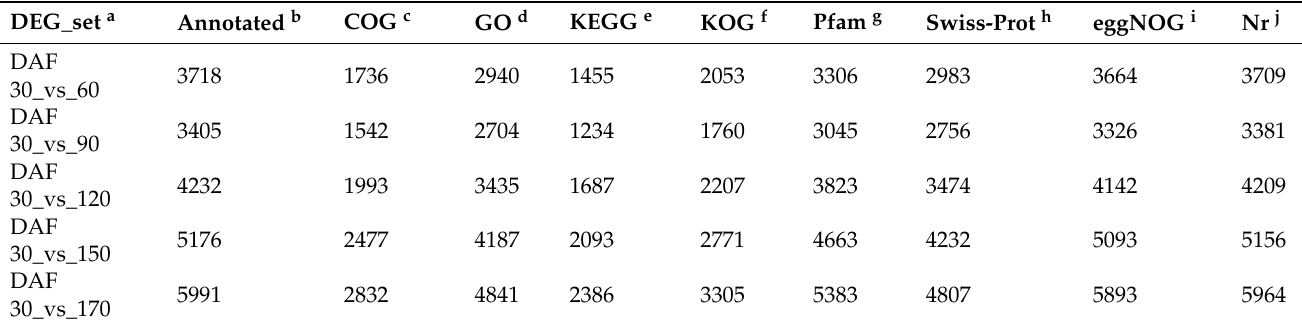
Table 2. Annotation summary of every DEG set among the six developmental stages of fruit develop- ment and ripening of A. latifolia